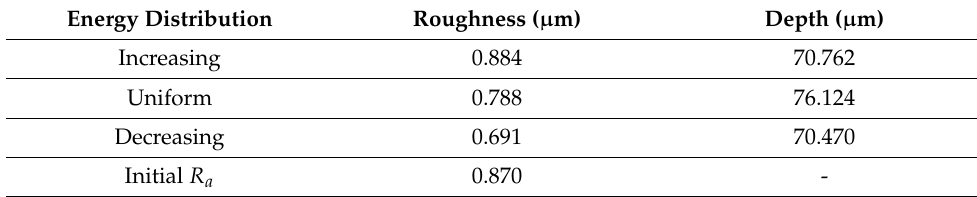
Table A3. Roughness and depth of brass.